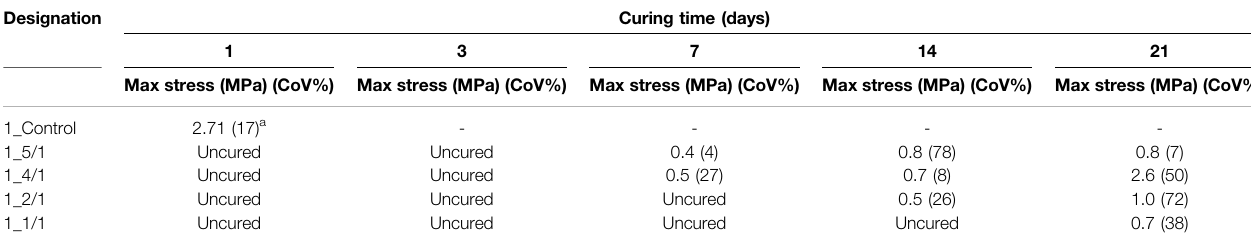
TABLE 7 | Pull off test results performed on samples with sanded surfaces.